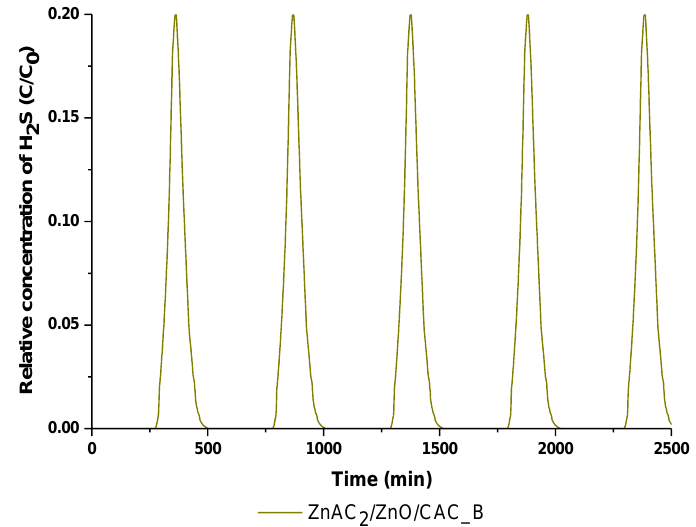
Figure 6. Regeneration profile of ZnAc 2 /ZnO/CAC_B. Table 4. Degradation of adsorption – desorption cycle.